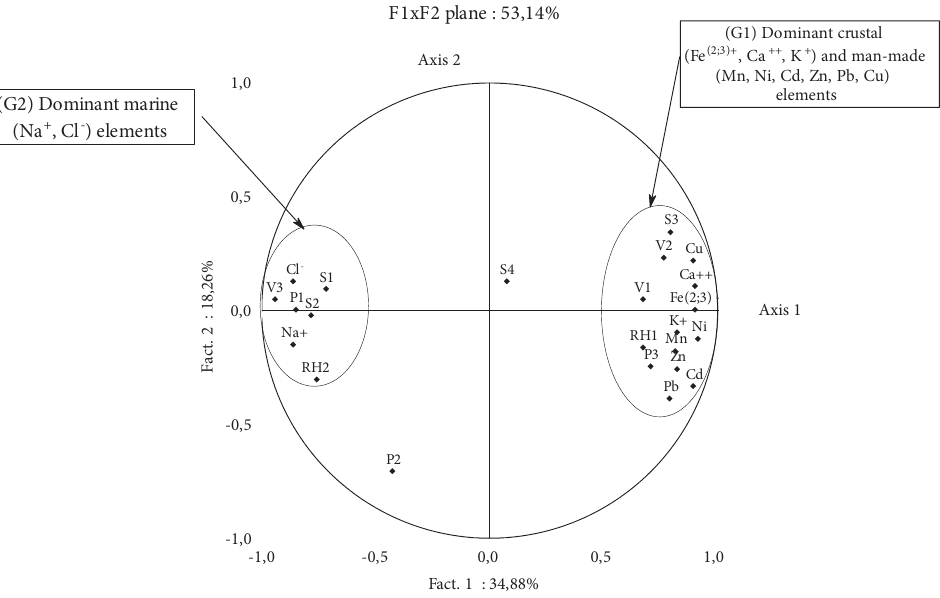
Figure 13. Distribution of biweekly fluxes constituents of particle deposition in the correlation circle (for S23 site; r = 0.42 for p < 0.05 and n = 22)